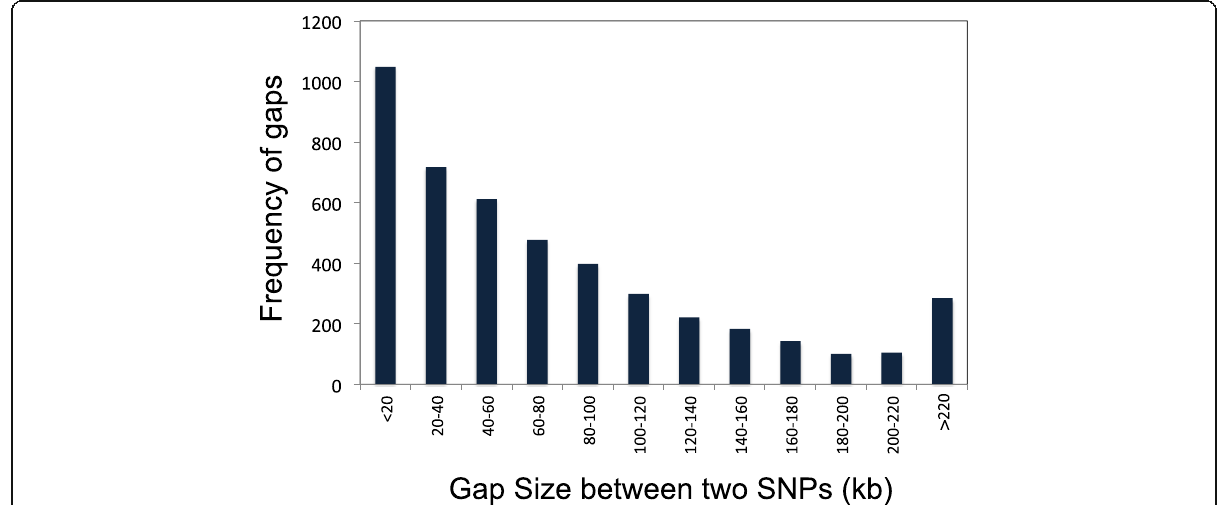
Fig. 1 Distribution of SNP distance to its neighboring SNP. More than 50% of SNPs are within 60 kb from a neighboring SNP. The average spacing between SNPs is 79 kb. About 10% of SNPs are >220 kb to the neighboring